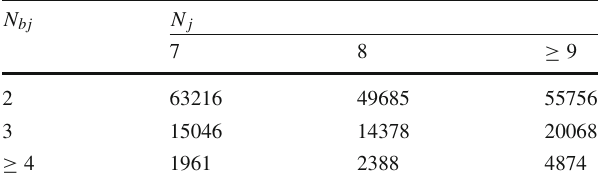
Fig. 4 Distribution of the number of jets ( N j ) and the number of b- tagged jets ( N bj ) in t ¯ t + multijets sample Table 1 Number of events in various N bj and N j regions in t ¯ t + multijets samples. The SR considered in this study requires N j ≥ 9